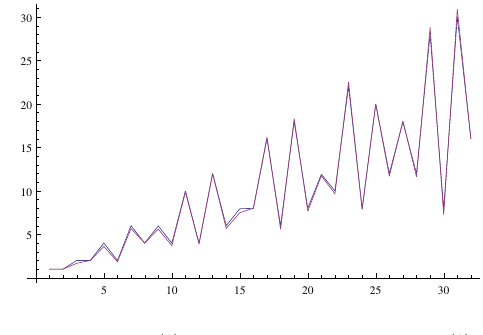
Figure 2 . Γ (1) plotted in units of Γ (1) cyc n from n = 1 to 32. The blue line is for ℓ = 1 while the purple line is for ℓ =